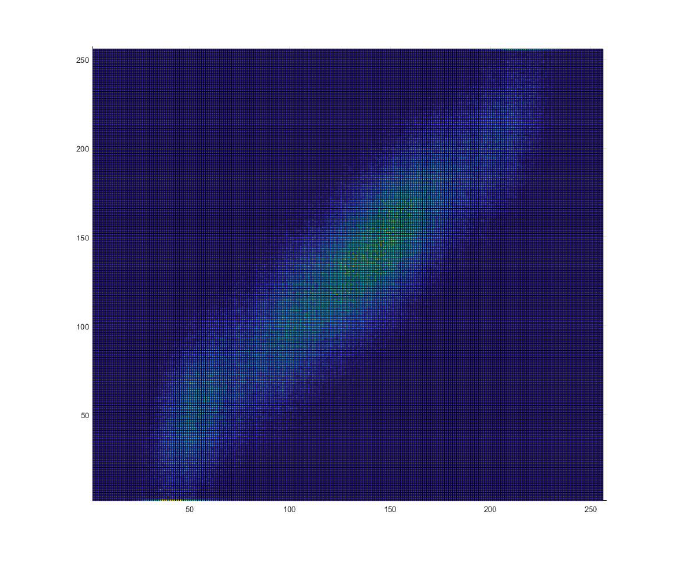
Figure 5. Two-dimensional gray histogram.